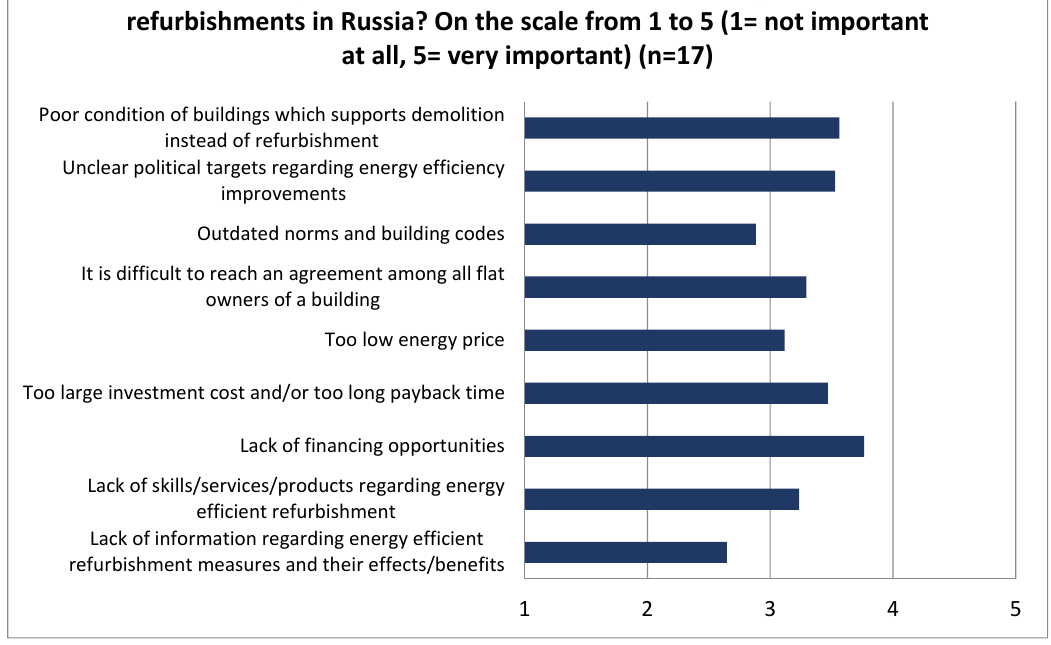
Figure 5. Main barriers identified by the respondents of the survey.